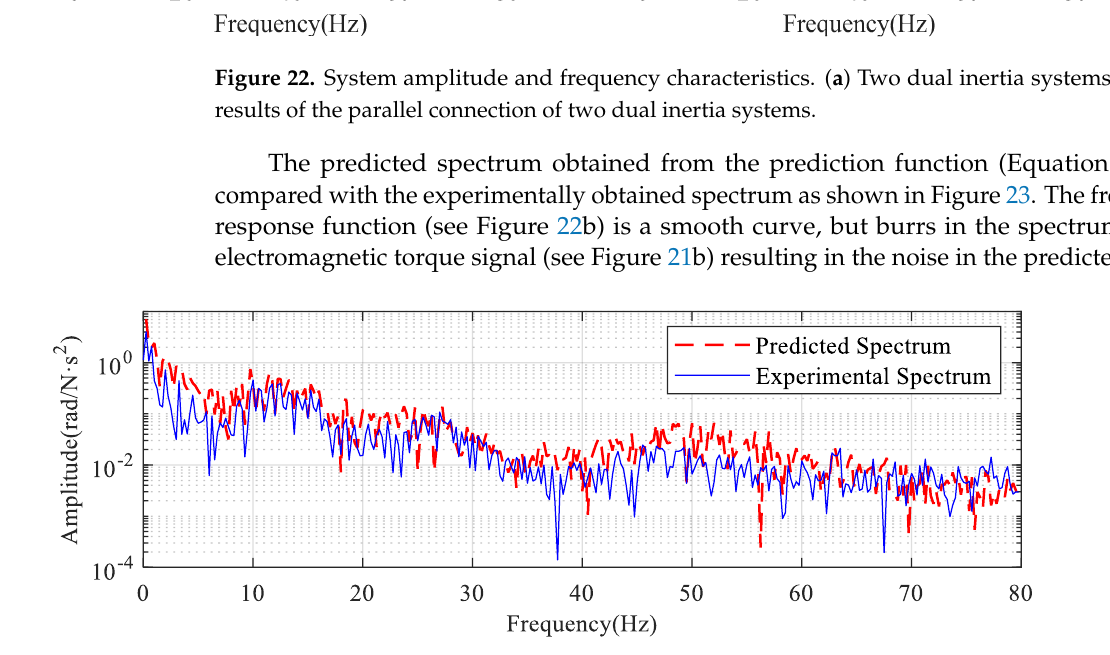
Figure 23. Comparison of predicted spectrum and actual